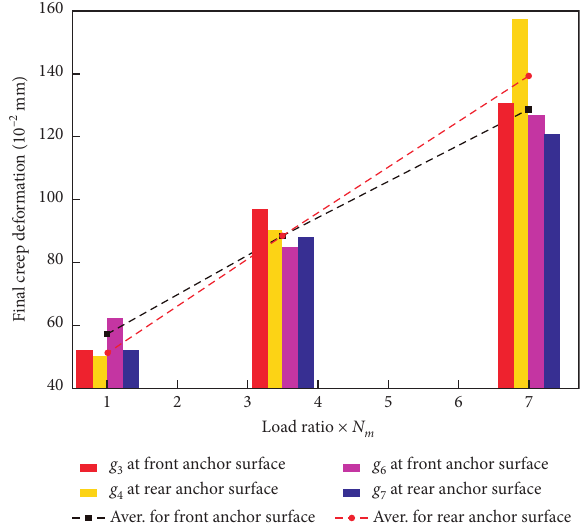
Figure 10: Comparison of creep deformations between two model